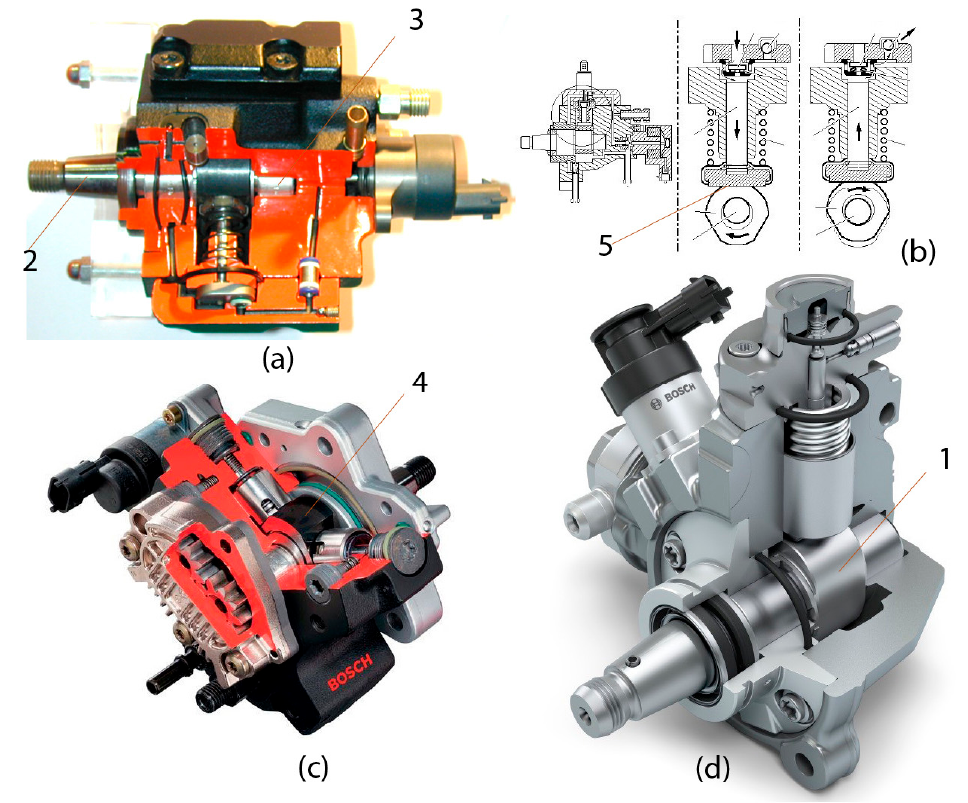
Figure 2. Comparative cross-section views of the different pump generations: CP1 ( a,b ), CP3 ( c ), CP4 ( d ).